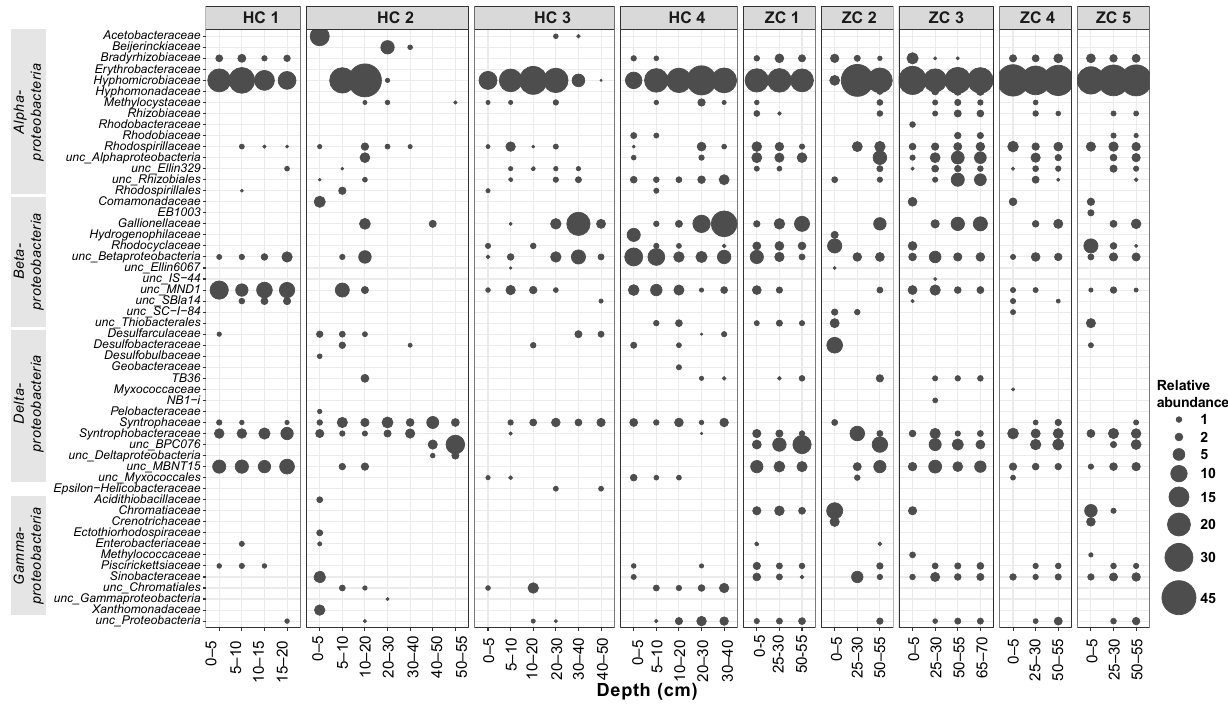
Figure 4. Relative abundances within Proteobacteria phylum in the study sites. Along the horizontal axis samples are arranged according to site and depth. The rank order along the vertical axis is shown for the family level. If an assignment to the family level was not possible the next higher assignable taxonomic level was